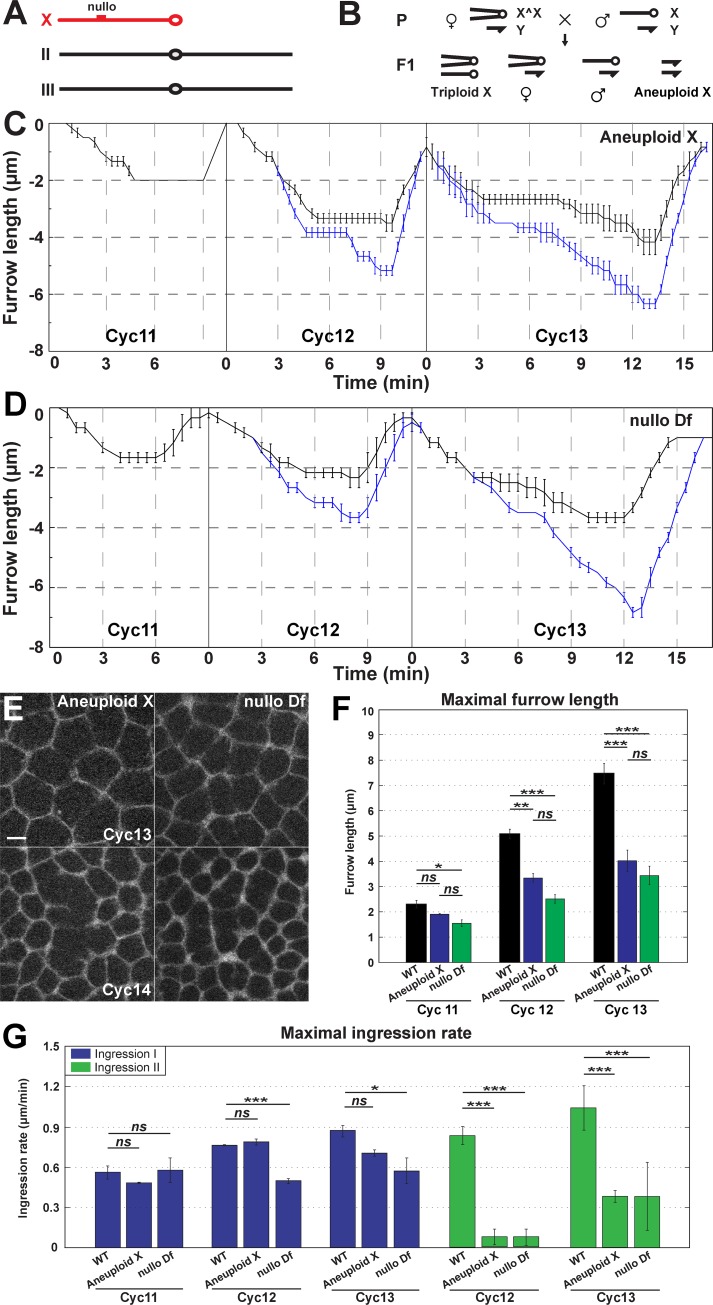
Regulation of furrow dynamics by X chromosome zygotic loci.(A) The major Drosophila chromosomes, with the telocentric X chromosome indicated in red. (B) Schematic depicting segregation of compound chromosomes generating X aneuploidy. (C) Aneuploid X chromosome embryo measurements of intact furrow depths (black curve) or deepest extent of fragmented furrows (blue curve) (n = 3). (D) nullo Df embryo measurements of intact furrow depths (black curve) or deepest extent of fragmented furrows (blue curve) (n = 3). (E) Disrupted furrow phenotype in aneuploid X and nullo Df embryos during cycle 13 and slow phase of cycle 14. A region just adjacent to the furrow tips is shown. Scale bar = 5 μm (F) Maximal furrow length in WT, aneuploid X and nullo Df during cycles 11–13 (n≥3). *:p<0.05; **: p<0.005; ***: p<0.0005; ns: not significant. (G) Maximal furrow ingression rate of WT, aneuploid X and nullo Df during cycles 11–13 (n≥3). *:p<0.05; ***: p<0.0005; ns: not significant.